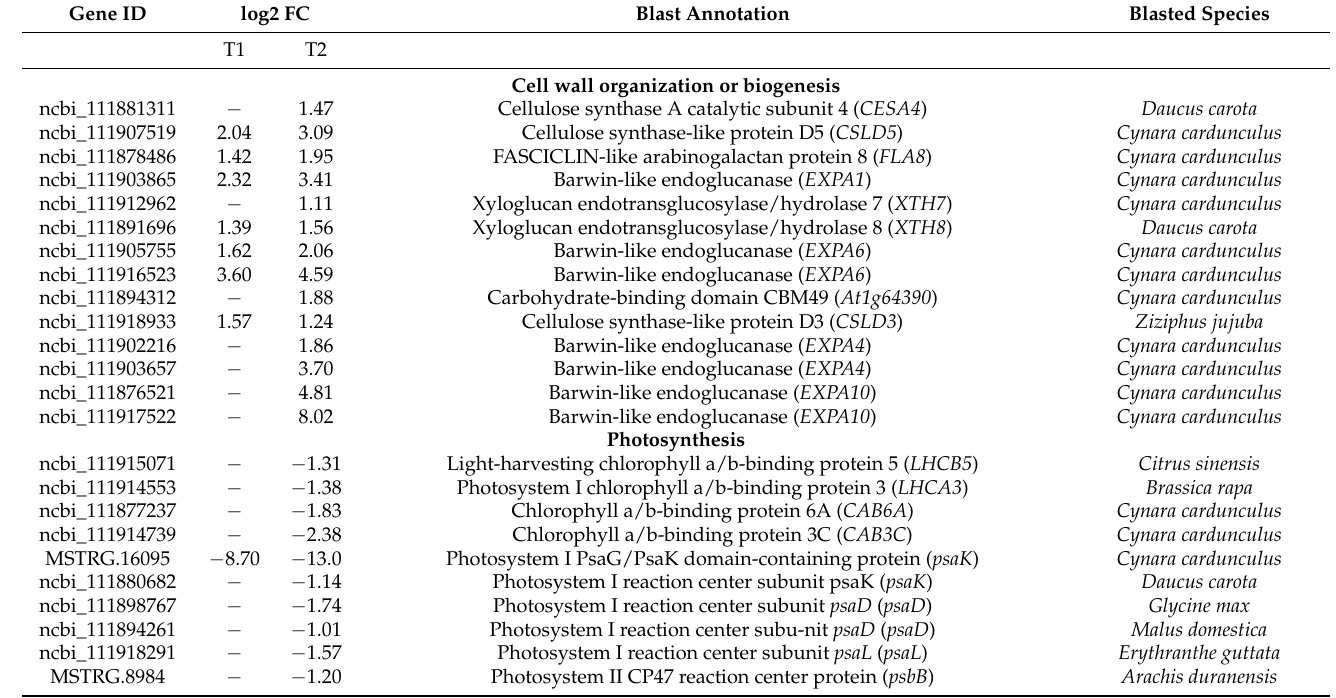
Table 2. Selected genes involved in cell wall organization or biogenesis, photosynthesis, oxidation-reduction process, antioxidant activity, transport, hormone signal transduction Gene